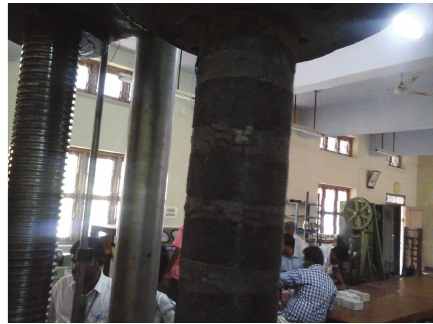
Figure 8: Failure pattern of NC-40-1.